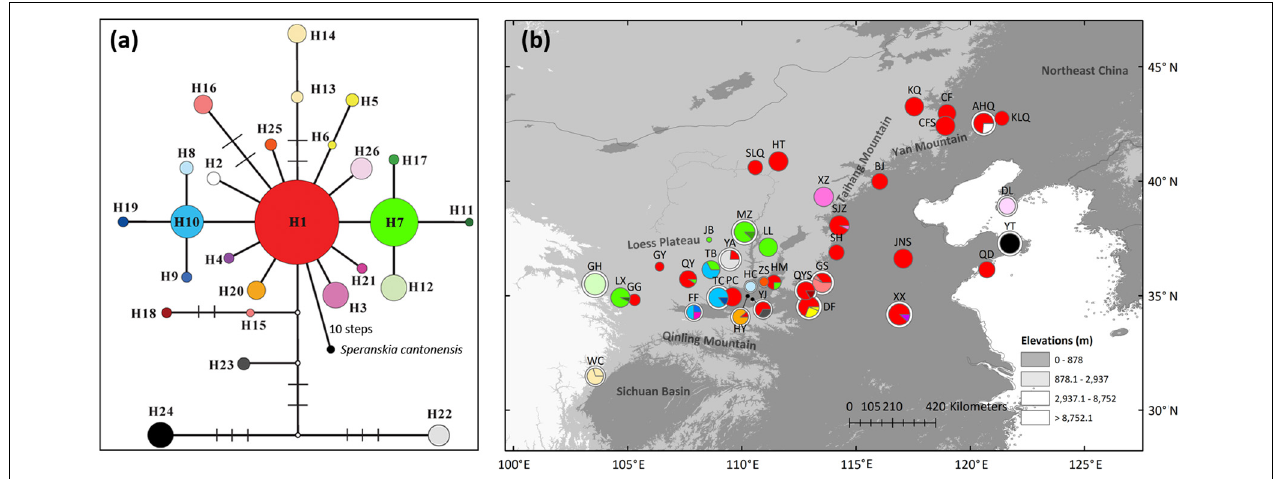
FIGURE 1 | Most parsimonious network (a) and geographic distribution (b) of 26 chloroplast DNA haplotypes of Speranskia tuberculata . In (a) , the small white dots without labels in the network represent missing alleles; S. cantonensis served as outgroup. Private haplotypes distributed only in one population are shown in the same color (H13 and H14 in WC, H15 and H16 in GS). In (b) , Populations that have private haplotypes are labeled with white outer ring. All circle sizes are proportional to sample sizes.